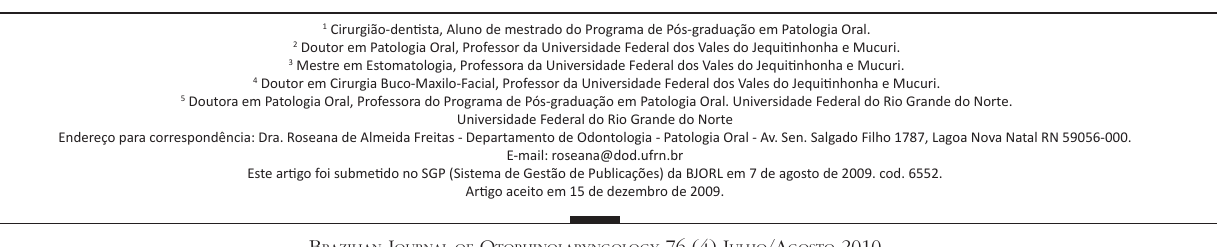
Figura 1. Achados histopatológicos - (A) Parênquima com estruturas ductiformes, composta por células internas com citoplasma eosinofílico e cúbico e a camada externa composta por células claras - HE; (B) Imunopositividade para CK 7 - SABC; (C) Imunopositividade para CK 8 - SABC; (D) Imunopositividade para SMA -